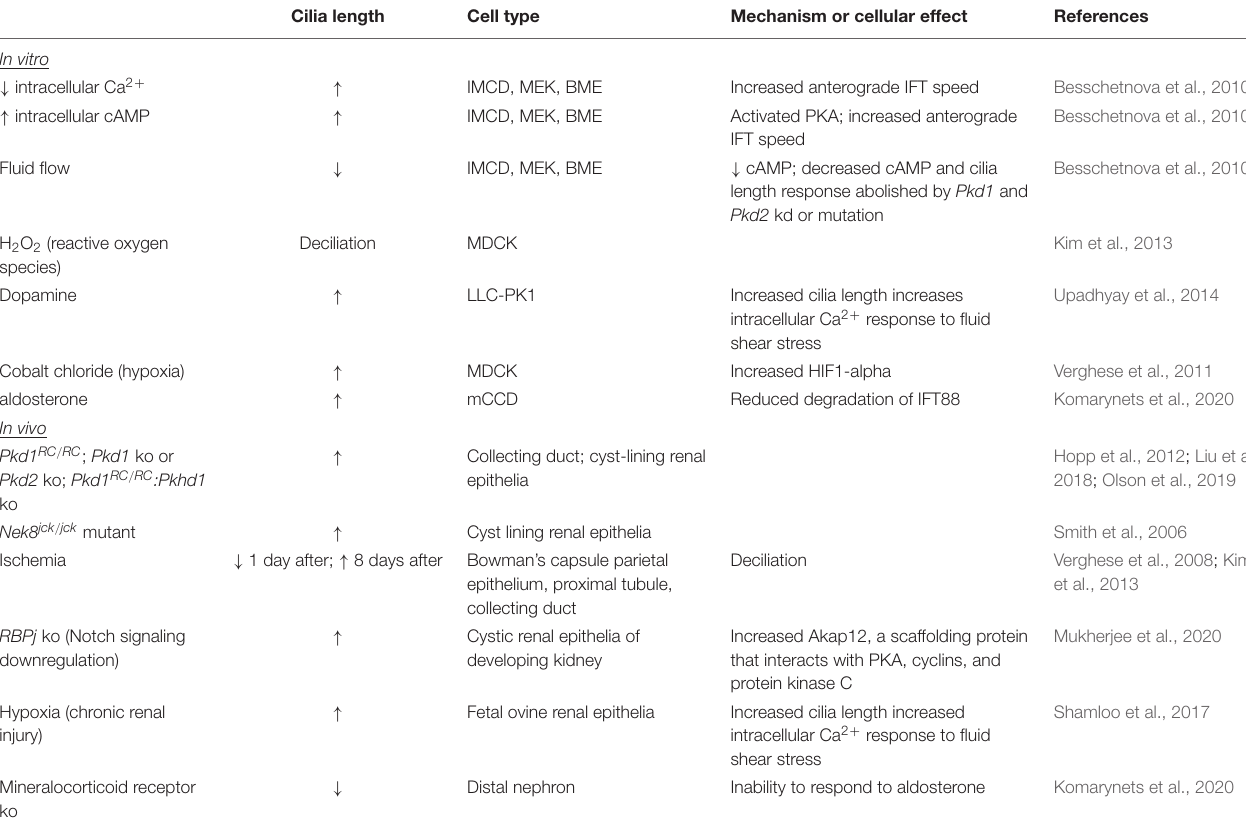
TABLE 4 | Modulators of renal cilia